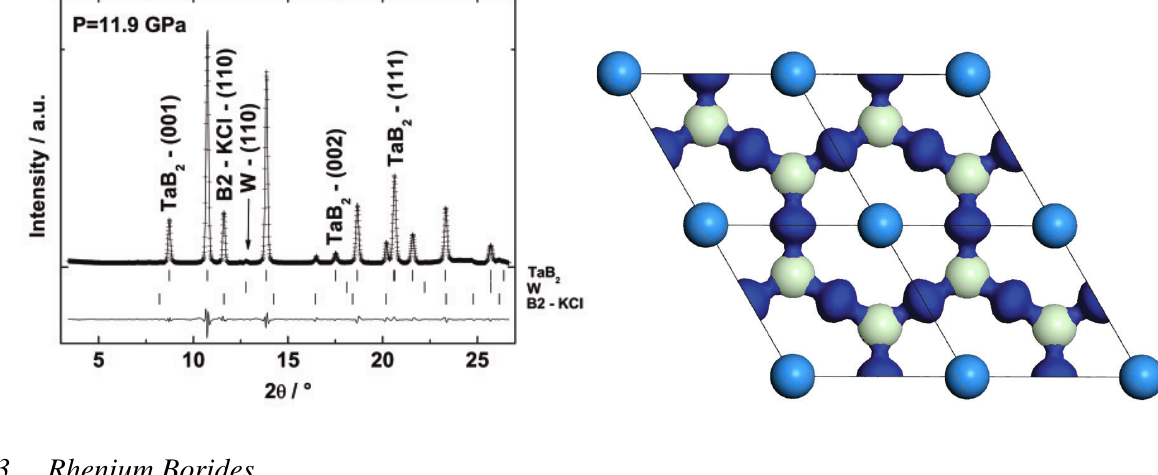
Figure 18. Left: X-ray diffraction pattern after laser heating ( λ = 0.4958 ˚A). Right: Electron density difference isosurface at 0.07 e − / ˚A 3 . The medium grey (medium blue) spheres at the corners of the unit cells are Ta atoms. The light grey (light green) spheres represent B-atoms at z = 1 . The dark grey (dark blue) isosurface shows the difference between the 2 self-consistent charge distribution and the electron density of superposed, non-interacting atomic electron